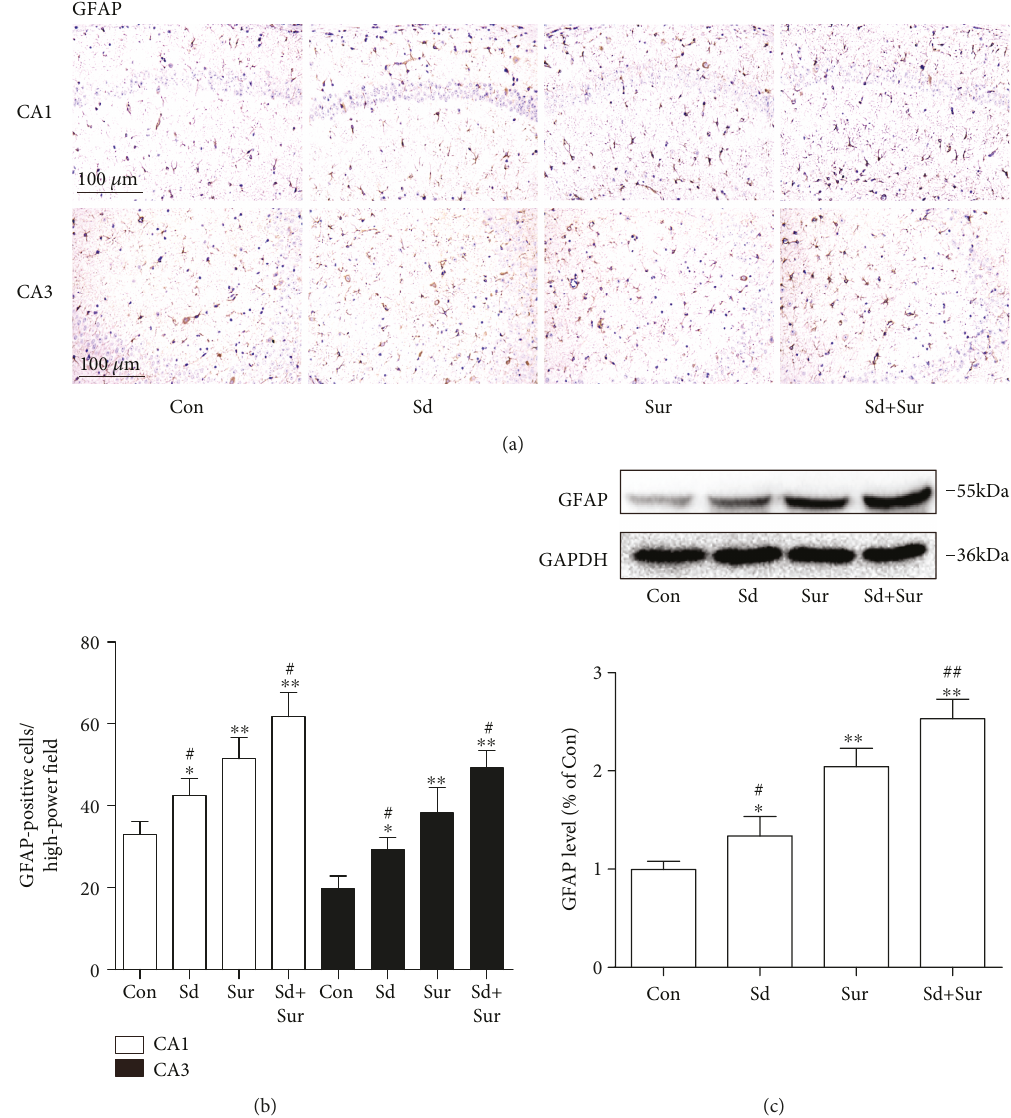
Figure 5: Preoperative sleep disturbance accelerated surgery-induced astrocyte activation in the hippocampus. (a) Representative images of activated astrocytes in areas CA1 and CA3 of the hippocampus based on staining with an anti-GFAP antibody. Scale bar: 100 μ m. (b) Quanti fi cation of GFAP-positive cell areas CA1 and CA3 of the hippocampus. (c) Expression levels of GFAP protein. The data are presented as the mean ± sem ( n = 4 ). ∗ P < 0 05 and ∗∗ P < 0 01 vs. the Con group; # P < 0 05 and ## P < 0 01 vs. the Sur